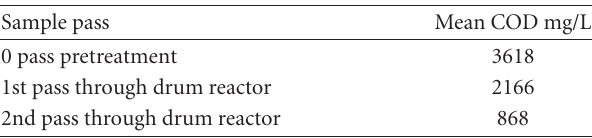
Table 1: Mean COD values for pretreatment, 1st pass and 2nd pass through the drum reactor.